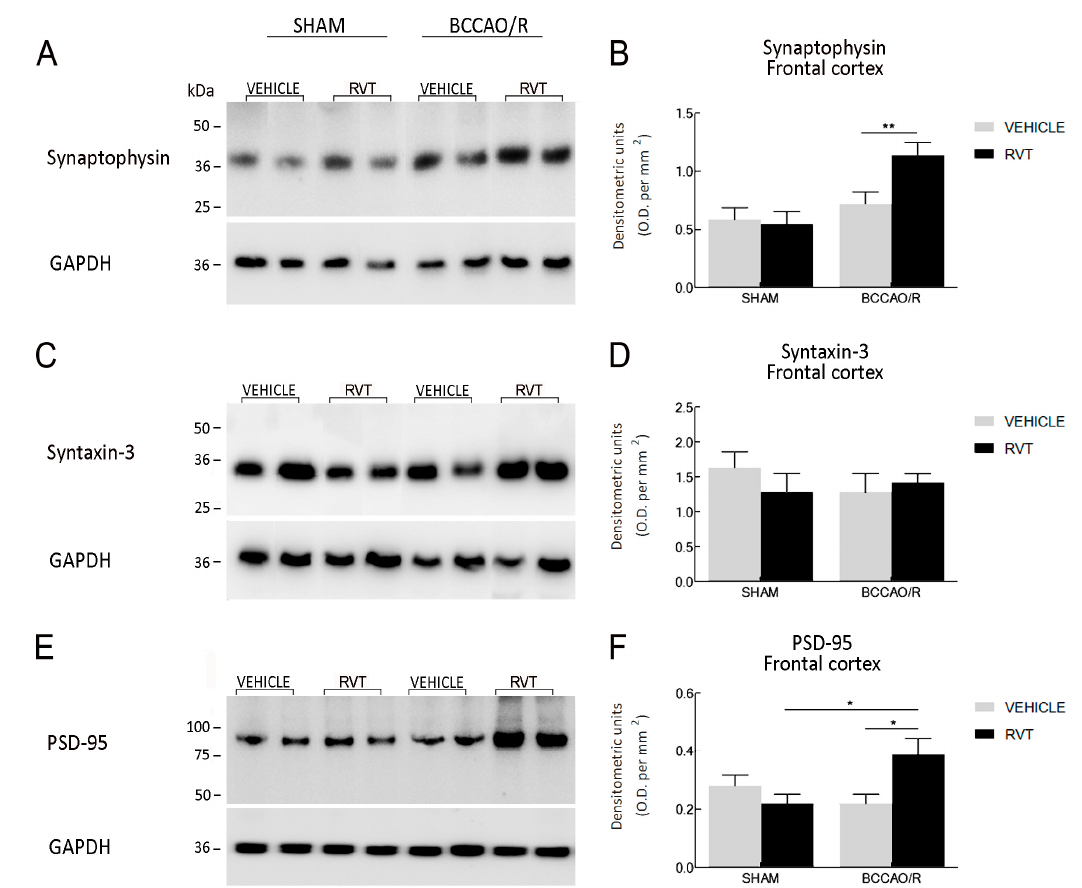
Figure 3. Western blot analysis of synaptophysin ( A , B ), syntaxin-3 ( C , D ) and post-synaptic density-95 (PSD-95) ( E , F ) synaptic proteins in the frontal cortex of sham and bilateral common carotid artery occlusion followed by reperfusion (BCCAO/R) vehicle-treated and RVT pre-treated rats, respectively. ( B , D , F ) densitometric analysis of the band gray levels expressed as a percentage of the optical density (O.D.) ratio of PPAR- α - and COX-2-immunostained bands to those of GAPDH. Data are reported as the mean values of 12 sham-operated and 12 BCCAO/R rats and 10 RVT pre-treated, either sham-operated or BCCAO/R, rats. Error bars depict the standard error of the mean (S.E.M.). Asterisks denote significant differences. Two-way ANOVA with the Bonferroni’s test for post hoc analyses was applied to evaluate statistical differences between groups. * p < 0.05; ** p < 0.01